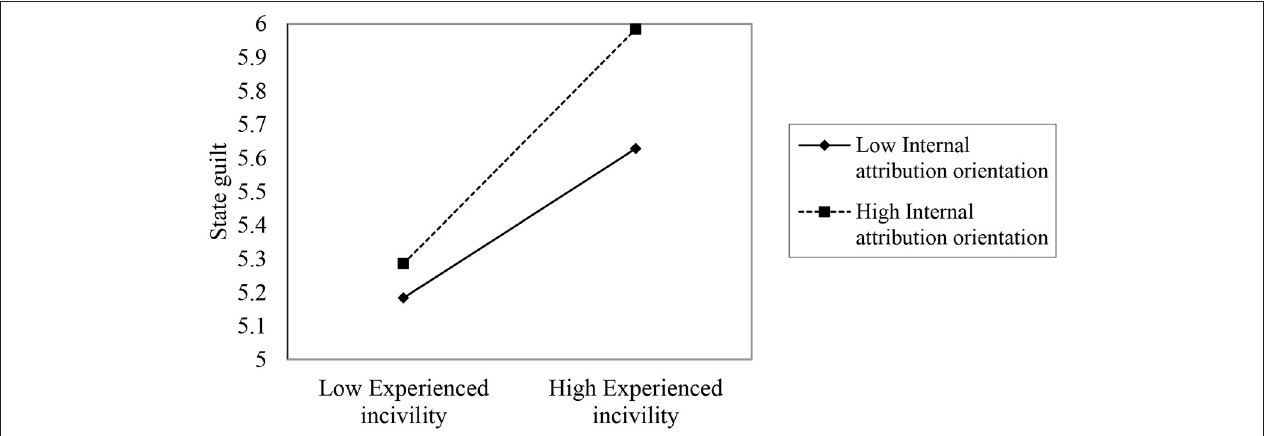
FIGURE 2 | The moderating role of internal attribution